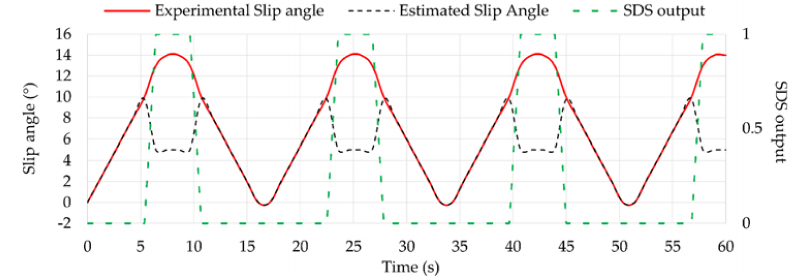
Figure 18. Tire slip detection from the slip angle estimation.